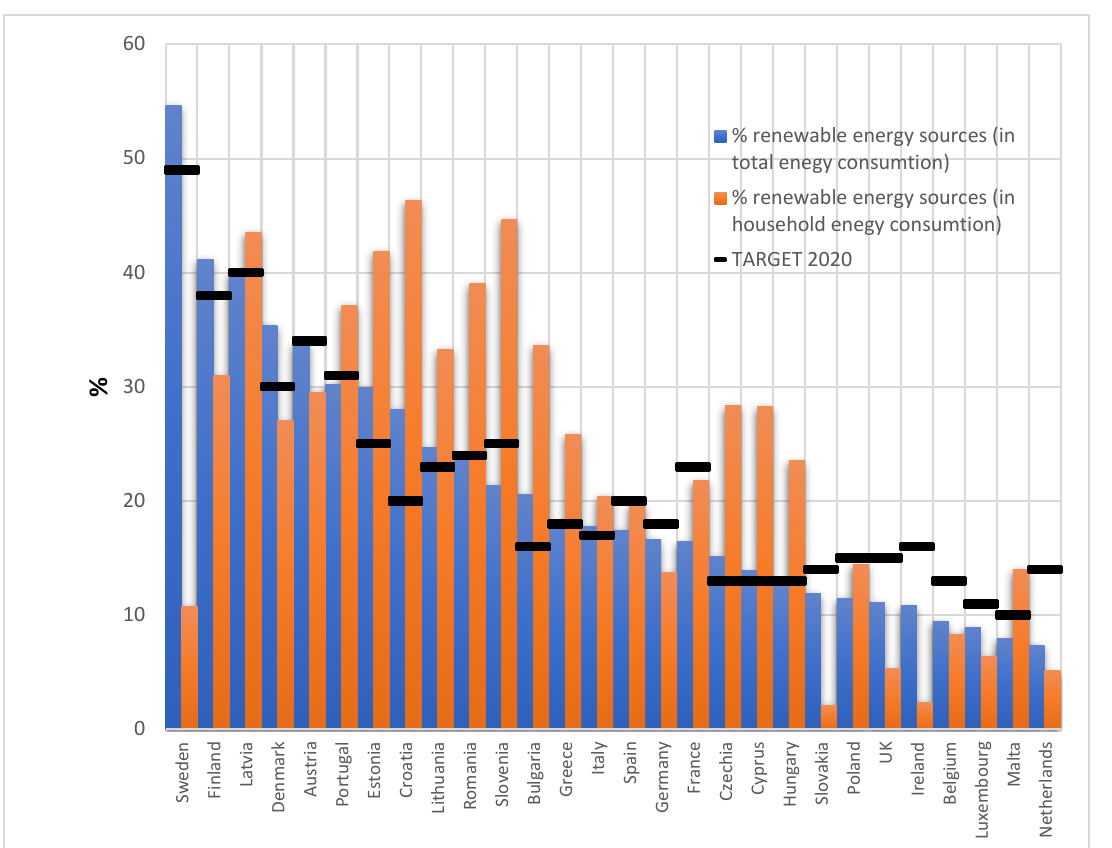
Figure 1. Share of energy from renewable sources and biofuels in total energy consumption and household energy consumption, Source: Eurostat